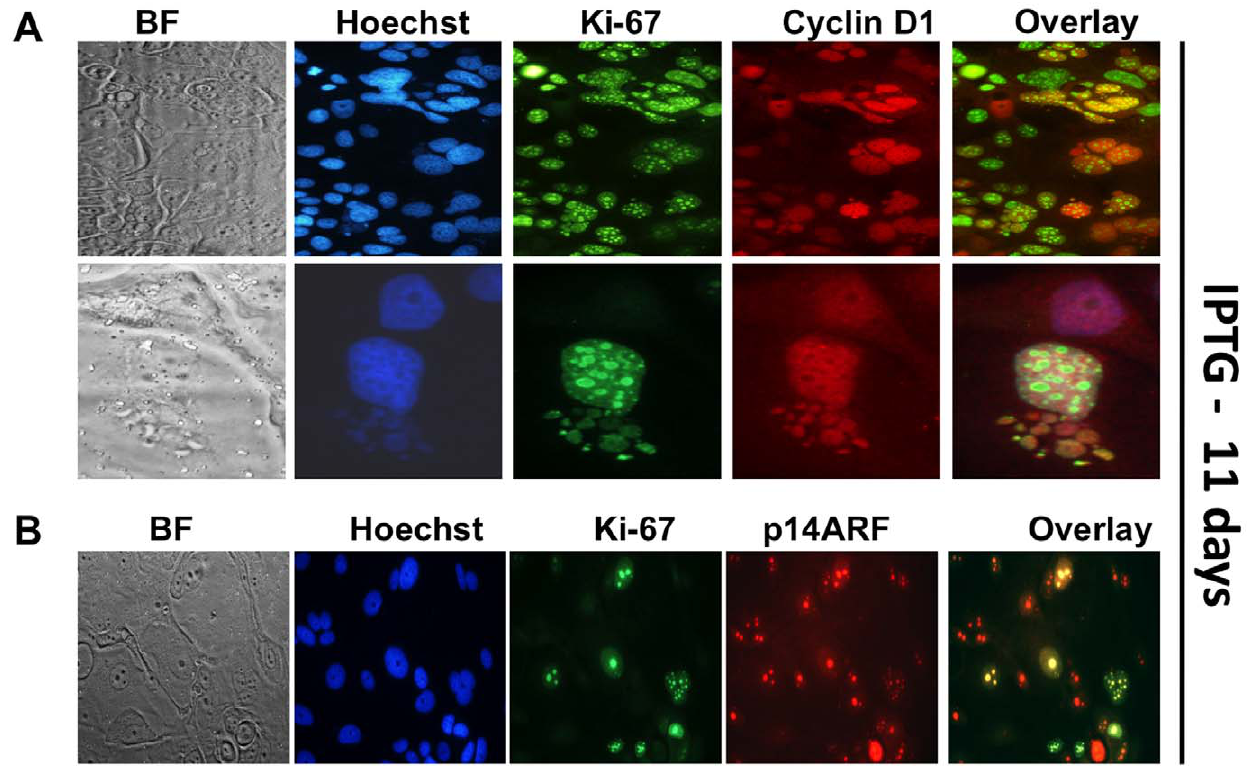
Figure 7. Abnormal nuclear growth and proliferation is associated with co-expression of cyclin D1 and Ki-67 in the nucleolus of latent p14ARF cell cycle arrested cells. MCF-7 cells were seeded on cover slips for 48h and subsequently treated with 5 mM IPTG for a further 11 days. A. Cells were fixed and immunofluorescent stained for cyclin D1 (red staining), Ki-67 (green staining), and Hoechst 33342 (blue staining). B. Cells were stained for p14ARF (red staining). Images were taken on a Nikon fluorescence microscope (magnification